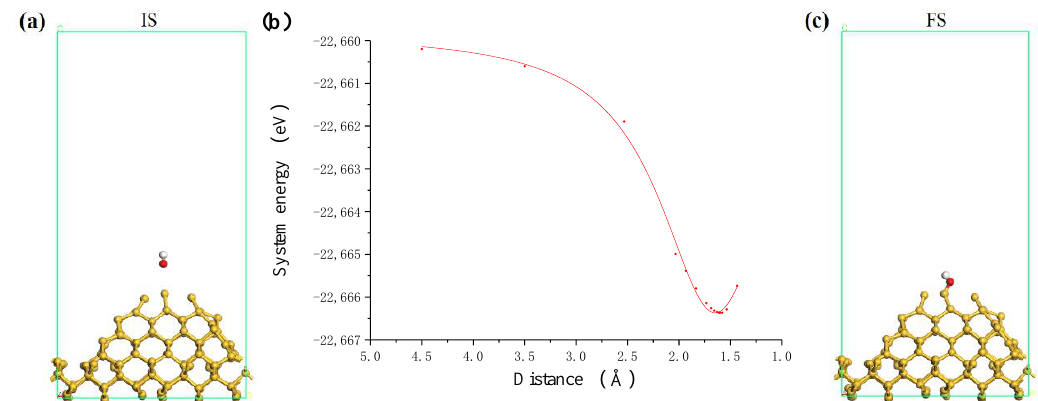
Figure 5. The process of OH group adsorbing on Si surface. ( a ) Initial state; ( b ) system energy; ( c ) final state where white and balls are hydrogen and oxygen atoms, respectively.